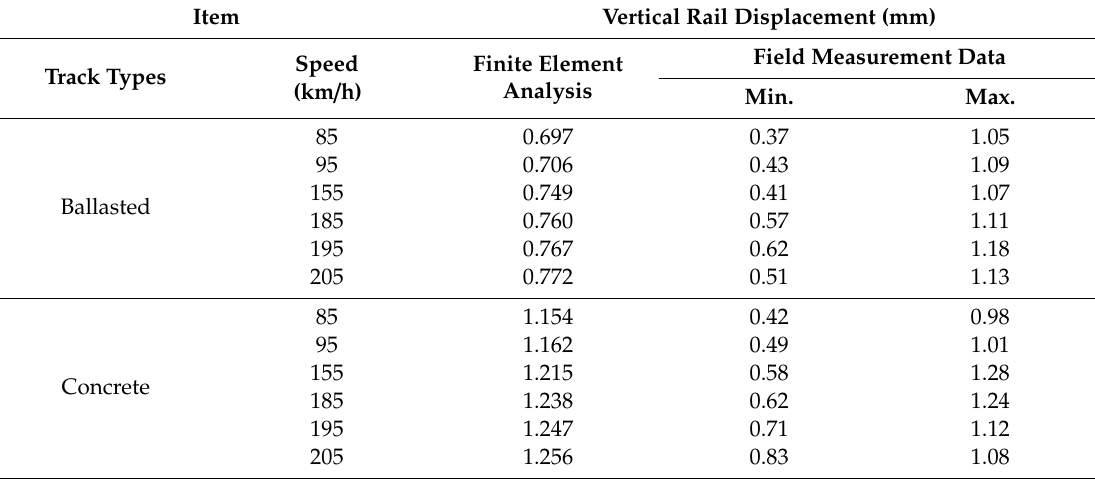
Table 8. Field measurement result and finite element method analysis